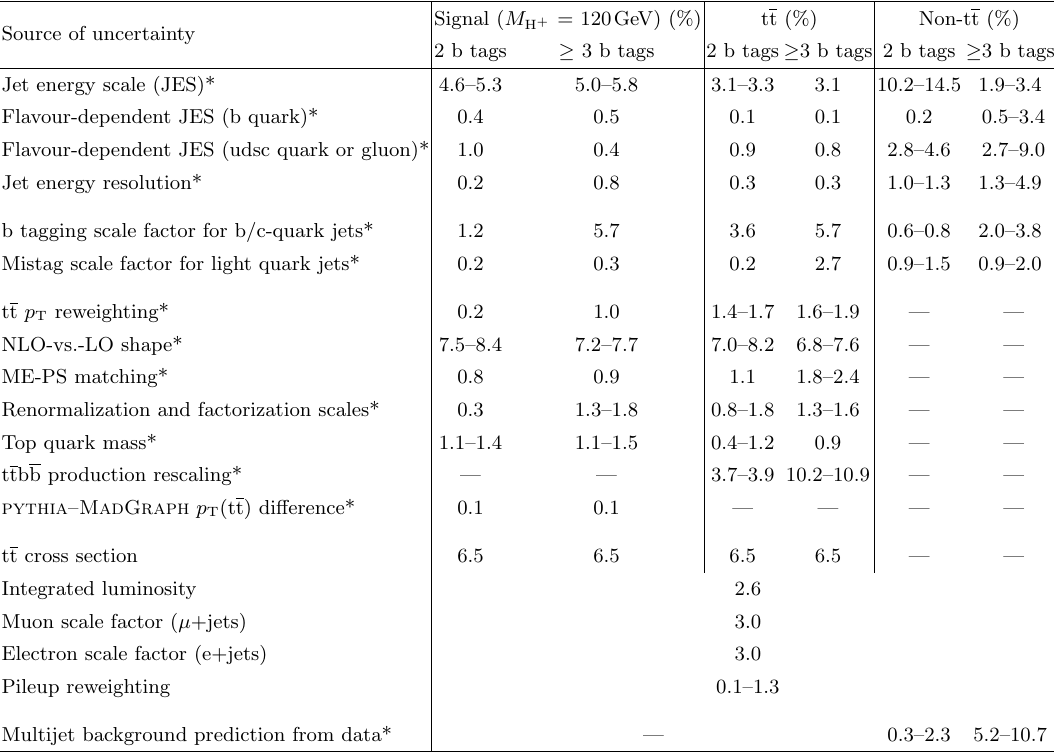
Table 2 . Summary of the relative systematic uncertainties in the event yields for the H + signal ( M = 120 GeV), simulated SM backgrounds (separated into tt and non-tt components), and the H + data-driven multijet events. The uncertainties apply to both (cid:22) +jets and e+jets events, and in the case where the uncertainties in the two channels di(cid:11)er, a range is given. Uncertainties on the shape of templates are marked with an